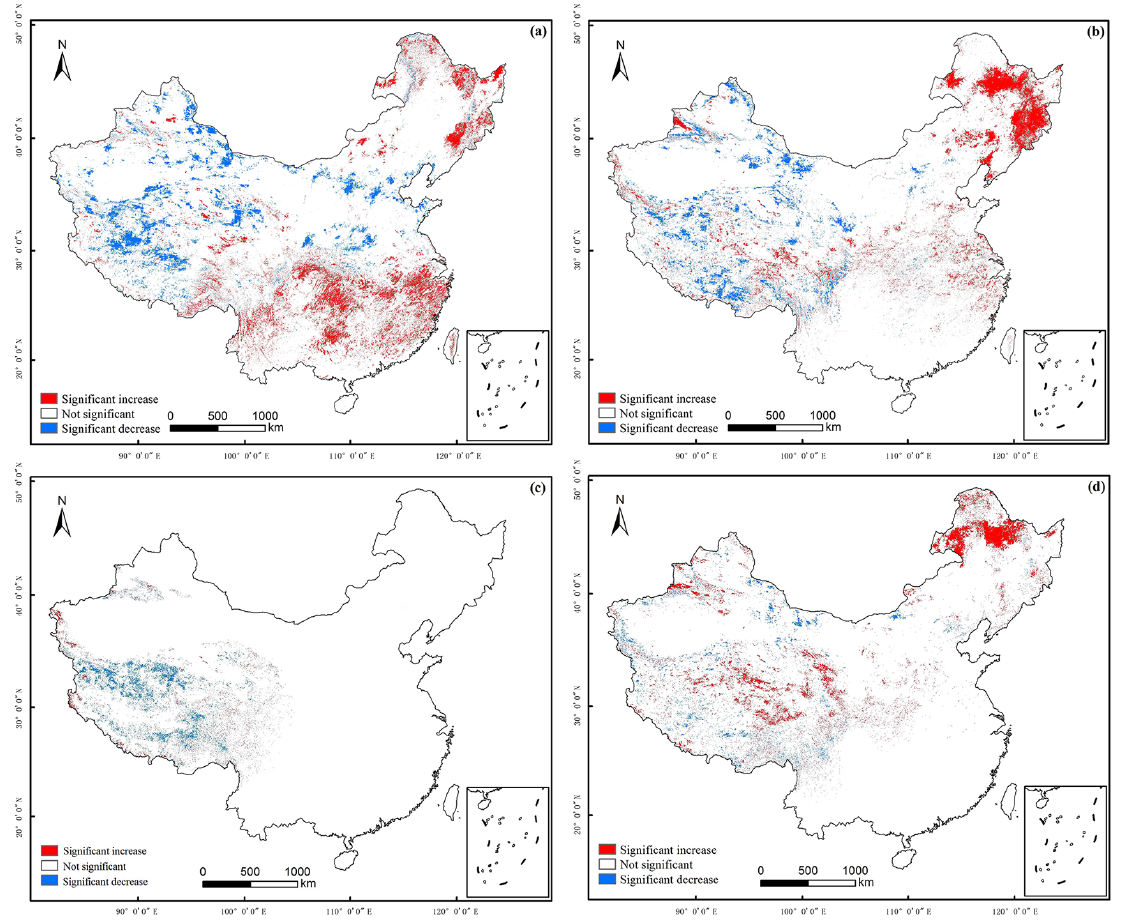
Figure 6. Variation in the number of SCDs during each season in China based on the Mann–Kendall method from 2001 to 2014. Panels (a) – (d) show the significance of the variation in the number of SCDs during the winter, spring, summer, and fall, respectively.